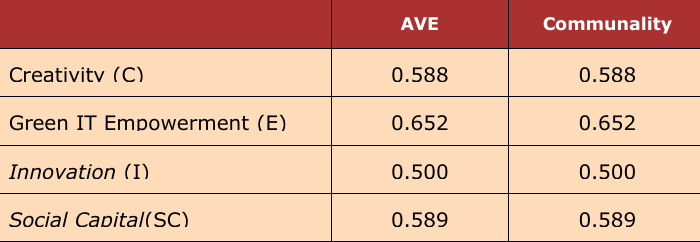
Table 5. AVE and